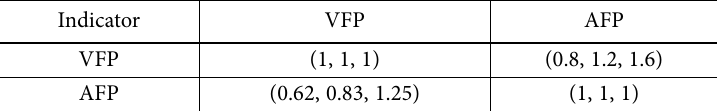
Table 5. Fuzzy pair-wise comparison matrix for the main-criteria VFP and AFP Indicator